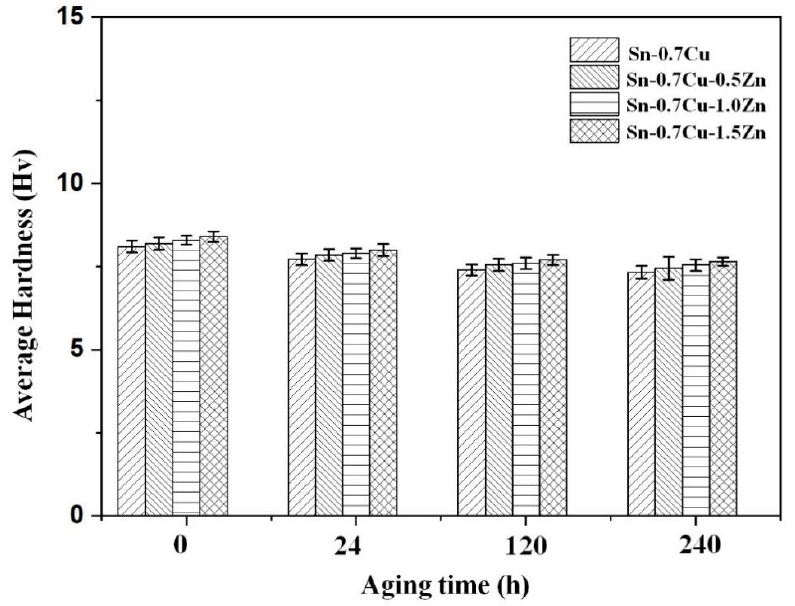
Figure 14. Average hardness after thermal annealing at 180 °C.